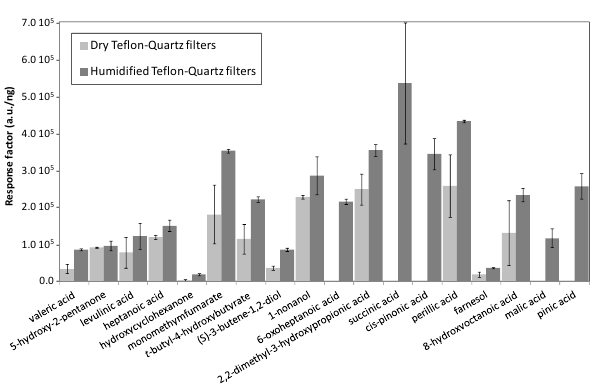
Fig. 12. Humidity influence on on-Teflon-quartz filters organic acids and hydroxyl compounds MTBSTFA-derivatisation. Comparison is based on response factors evaluated from 5 point calibration curves (5 to 320 ng). “Response factor” refers to FID chromatogram surface peak area per ng of compound, in area units. Error bars represent ± two standard errors given for a 95% confidence level.